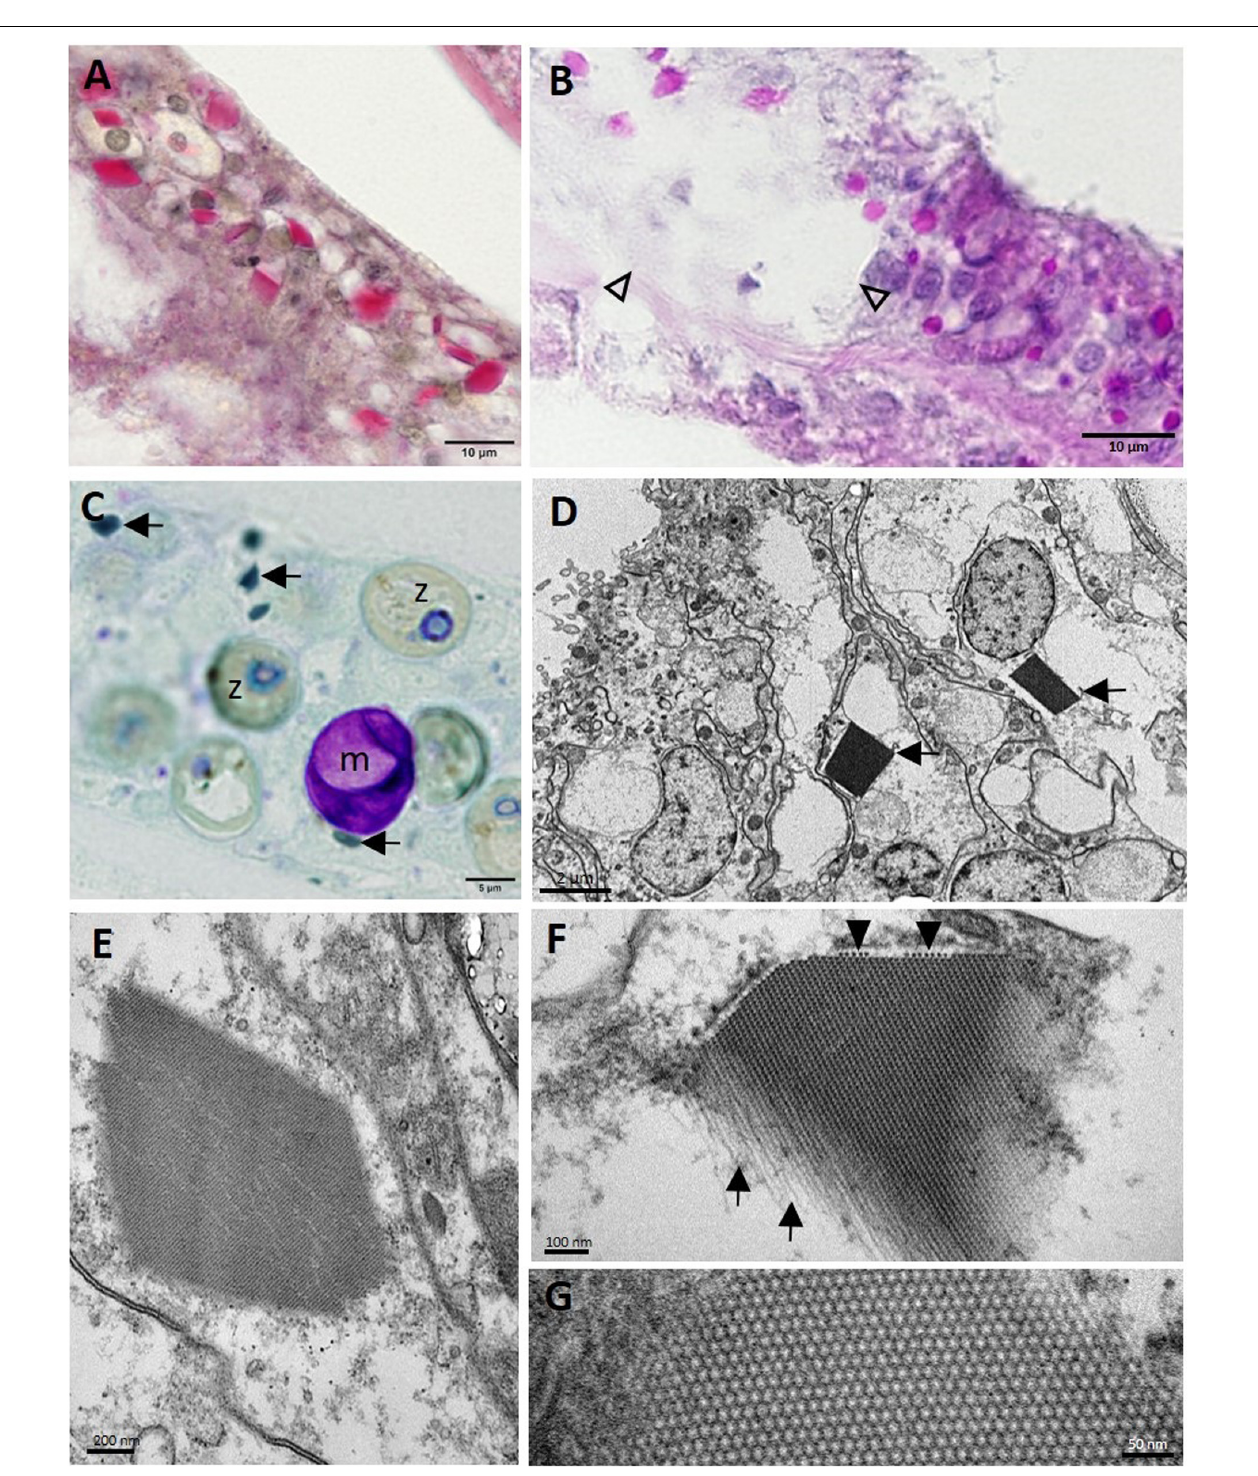
FIGURE 12 | Crystalline inclusion bodies (CIBs) in the basal body wall gastrodermis in Montastraea cavernosa . (A) Staining periodic acid–Schiff ( PAS)-positive (red). (B) Staining PAS-positive (pink-red) in LN lesion (arrowheads) and adjacent gastrodermal tissue. (C) Dark green − staining CIBs (arrows). (D) Two CIBs (arrows) each in the cytoplasm of a degenerating mucocyte. (E) CIB showing striated appearance. (F) High magnification of a CIB showing the filamentous tubular appearance (arrows) and cross section of tubules (arrowheads) that form the striations seen in (E) . (G) High magnification of CIB showing the lattice pattern of the individual tubes or filaments in cross section. (A) Periodic acid–Schiff–metanil yellow (PAS-MY), JB-4 medium; (B) PAS, paraffin medium; (C) toluidine blue, semithin section; (D–G) transmission electron microscopy (TEM). m, mucocyte; z, zooxanthella.